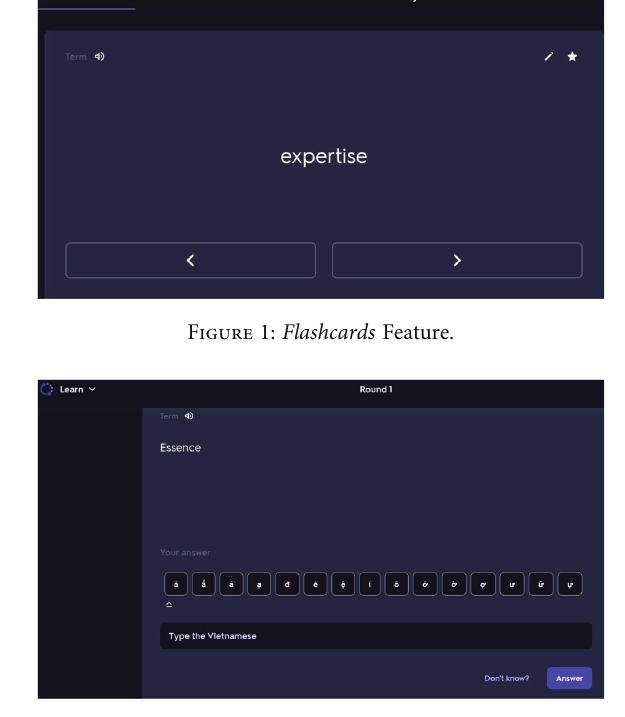
Figure 2: Learn Feature.